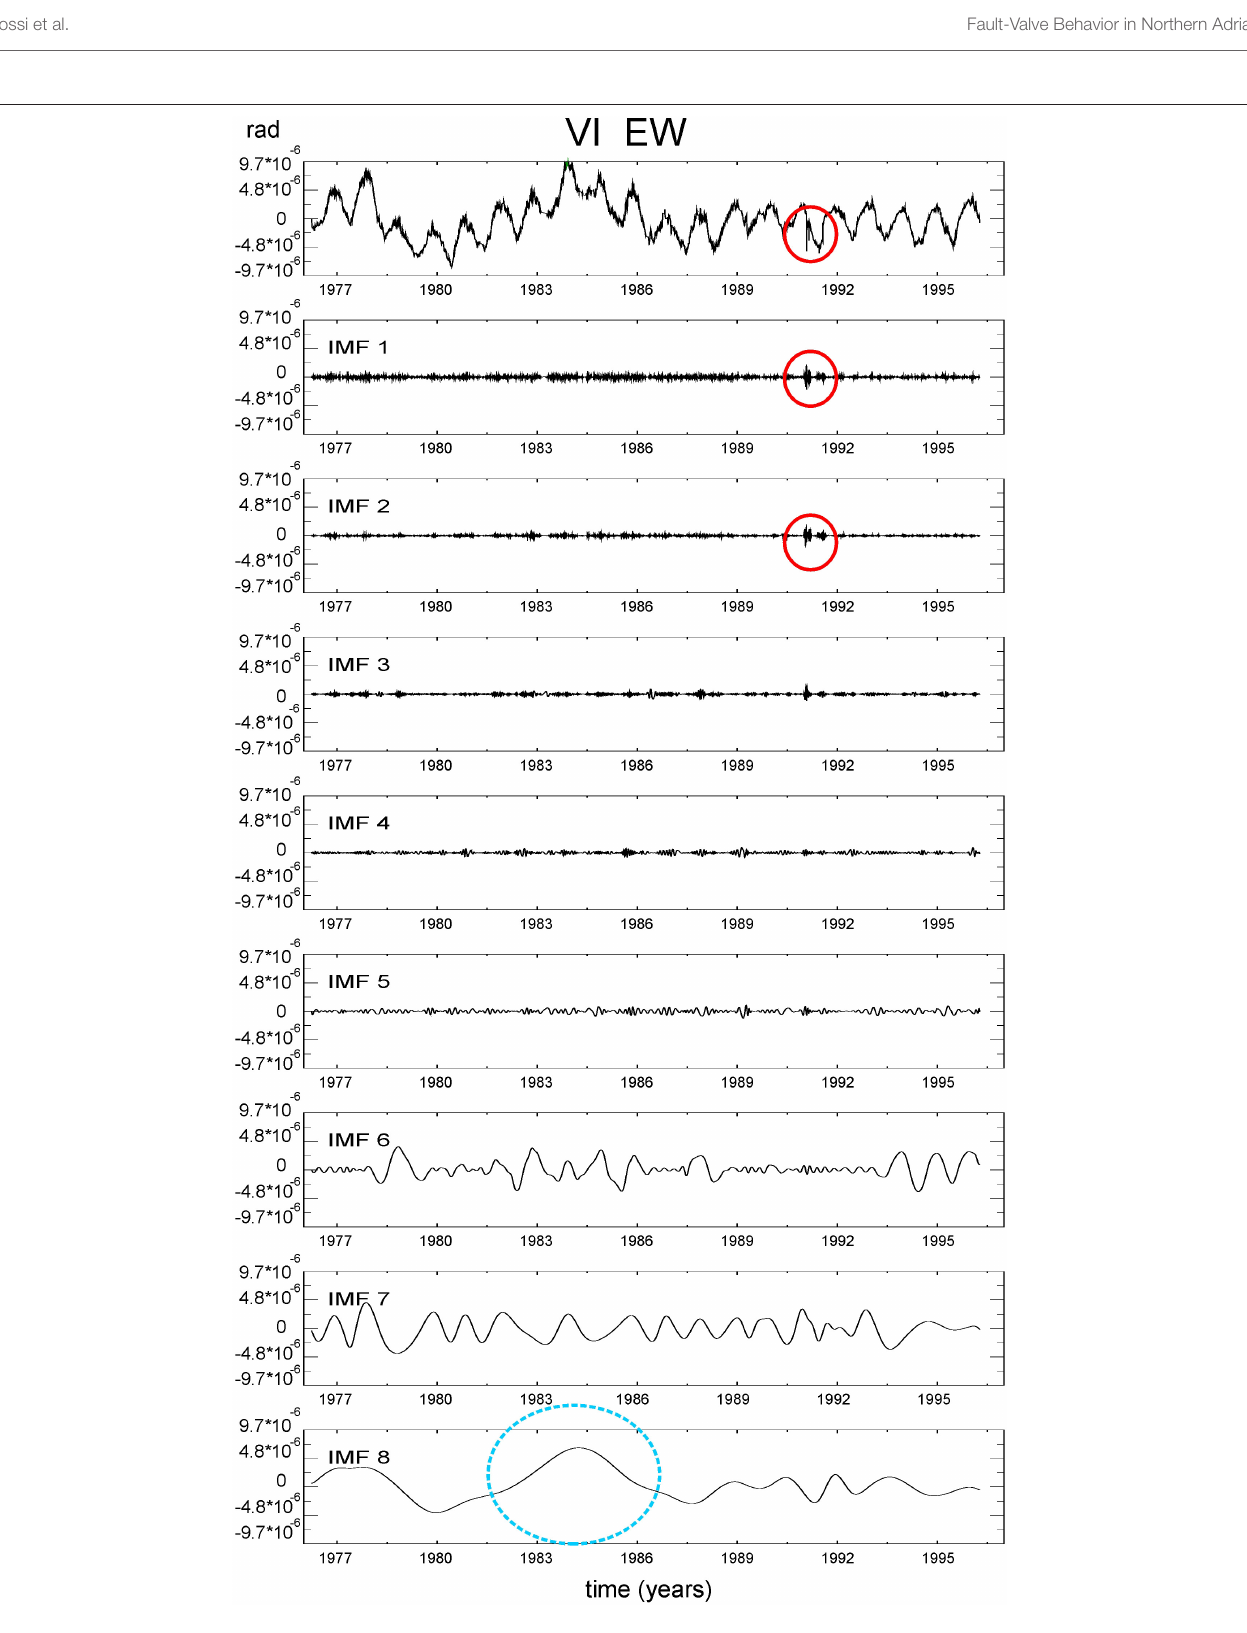
Frontiers in Earth Science |